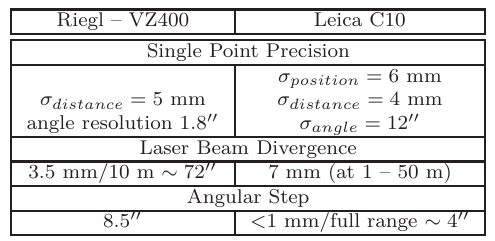
Table 2: Technical specification of used scanners